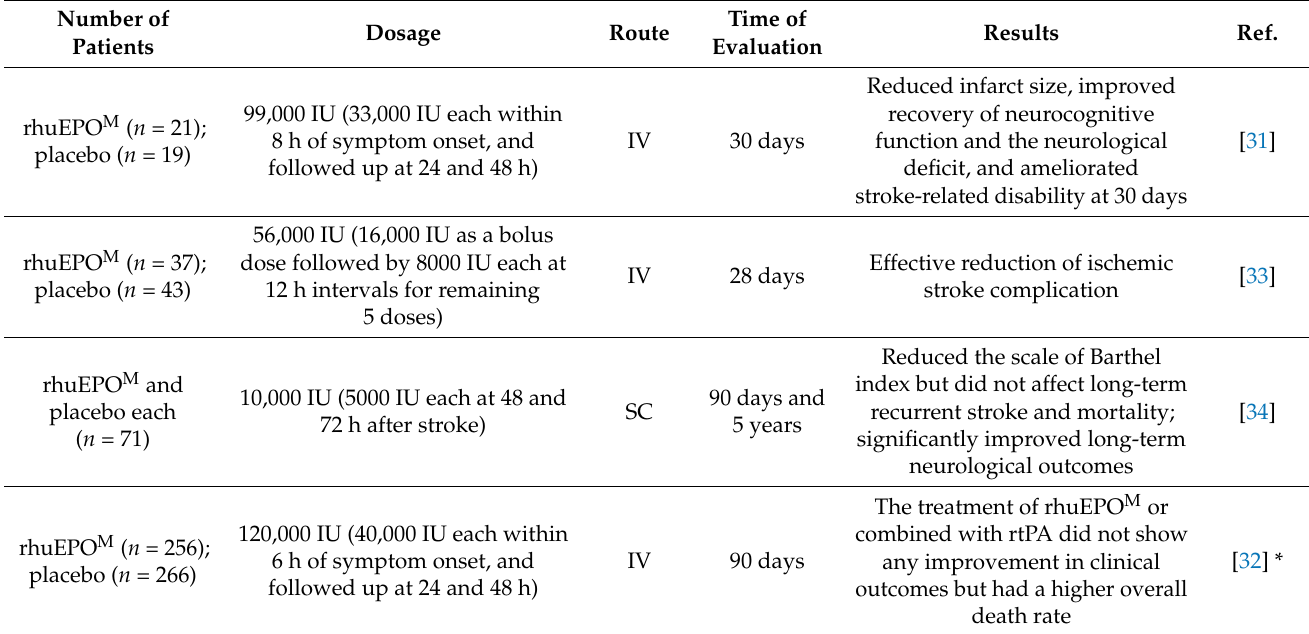
Table 2. Clinical trials of rhuEPO M treatment for acute ischemic stroke